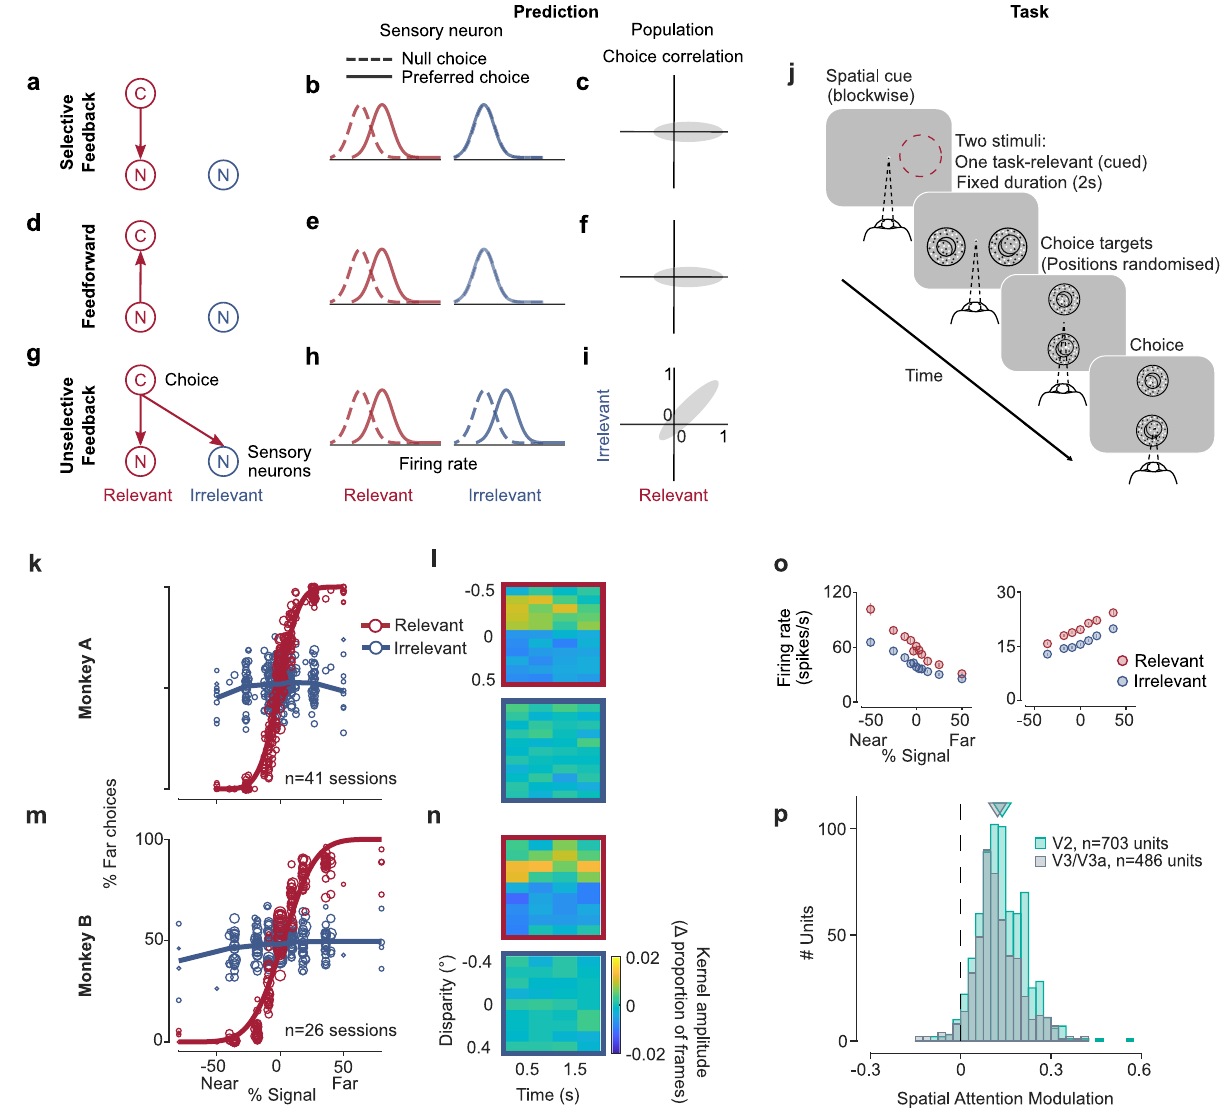
Fig. 1 Predictions, task, and behavior. a – i Predictions for choice correlations of visual neurons representing a task-relevant or an ignored, task-irrelevant stimulus. Neurons representing relevant (red) and irrelevant (blue) sensory information (N), or choices (C). Middle column: Firing rate distributions of sensory neurons representing relevant (red) or irrelevant (blue) stimuli, separated for trials on which the observer chose a neuron ’ s preferred (solid) or null stimulus (dashed). Right column: Distribution of choice correlations across a population of sensory neurons representing the relevant (abscissa) or irrelevant (ordinate) stimulus. For selective feedback ( a – c ) or feed-forward processes ( d – f ) choice correlations are only expected for neurons representing the task-relevant stimulus. If feedback is unselective choice correlations are also expected when neurons represent the irrelevant stimulus ( g , h , i ). For feature-discrimination tasks, spatially global feature-based attention predicts such unselective modulation if these feedback processes are linked. j Monkeys performed a disparity discrimination task on a cued stimulus while a task-irrelevant stimulus was simultaneously presented in the opposite hemi fi eld. The relevant hemi fi eld (red circle only for schematic) was indicated at the beginning of each block. k , m Psychophysical performance for each session ( n = 41, n = 26 for monkeys A and B, respectively; circle-size proportional to number of trials) for both monkeys and for the relevant (red, cumulative Gaussian fi t, psychophysical threshold: 12% (19%) signal for monkey A (B)) and irrelevant (blue) stimulus. l Psychophysical kernels (in proportion of frames per 0.5 s time-bin) computed for 0% signal trials (relevant, upper panel; irrelevant, lower panel) as a function of disparity and time for monkey A (trials: n = 5709 relevant, n = 5575 irrelevant). n Same as l but for monkey B (trials: n = 5355 relevant, n = 5203 irrelevant). o Tuning curves (spike rate as a function of % disparity signal; error bars show s.e.m., n = 16 – 111 repeats per condition) of two example units (left: V2 unit, monkey A; right: V3/V3a unit, monkey B) when the relevant (red) or irrelevant (blue) stimulus was inside the receptive fi eld. Responses are reduced for the irrelevant stimulus as expected for modulation by spatial attention. p Spatial attention index across the population for V2 (cyan, n = 703 units, mean = 0.14) and V3/ V3a (gray, n = 486 units, mean = the earliest site in the visual processing hierarchy for which sys- task-relevant (Fig. 2a, x -axis) or task-irrelevant (Fig. 2a, y -axis) tematic decision-related activity in disparity-based tasks have stimulus was in its receptive fi eld. Choice correlations quantify been observed 31 , and a subsequent processing stage, areas V3/ the degree to which a unit ’ s fi ring is correlated with an animal ’ s V3a, which has signi fi cant disparity selectivity 32 . We computed choice and are closely related (see “ Methods ” ) to “ choice prob- choice correlations for each unit separately for trials when the abilities ” (CPs) 15 (area under the receiver-operating curve